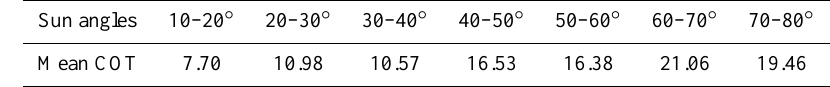
Table 1. Mean COT computed for the different sun incidences angles represented in the polar graphs in Fig.